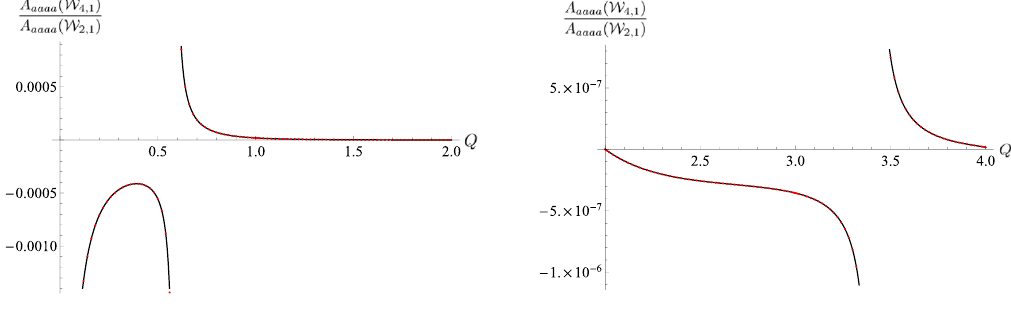
Figure 26 . The agreement of the bootstrap result of A aaaa ( W 4 , 1 ) in the regions 0 < Q < 2 and 2 < Q < 4